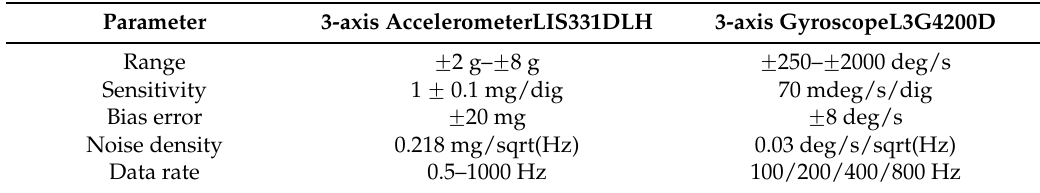
Table 1. The main parameters of the MEMS accelerometer and gyroscope embedded in the iPhone